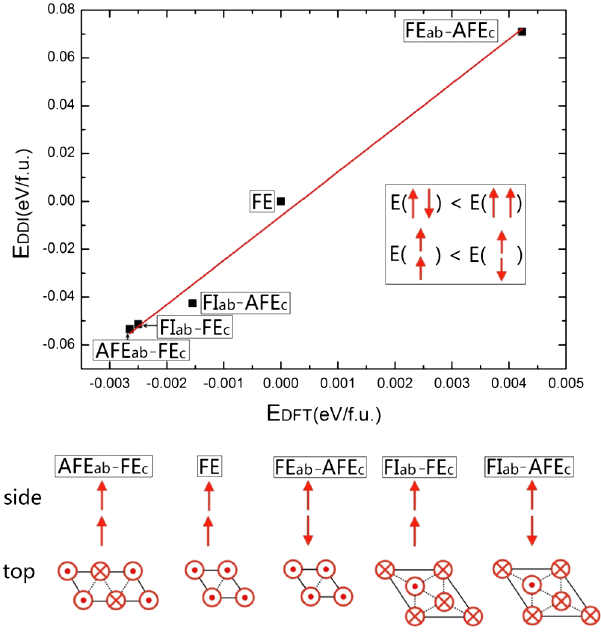
FIG. 2 Comparison of the results from the DDI model with those from the DFT calculations. The top panel plots the energies from the DDI model against the DFT energies for five different configurations (i.e., FE, AFE ab − FE c , FE ab − AFE c , FI ab − FE c , FI ab − AFE c ) of the local dipoles. The zero-energy reference is taken to be that of the FE state. A straight ¼ 18 . 5 E þ c ) is also shown. line from the linear fitting ( E DDI DFT The inset in the top panel schematically illustrates the idea that the two in-plane dipoles tend to be antiparallel to each other, while two dipoles along the c axis tend to be parallel to each other. The five dipole configurations are shown in the bottom panel. For the side view, we only indicate whether the dipole arrangement along c is AFE or FE. For the top view, crossed circle (dotted circle) represents the dipole along c ( − c ). The NN in-plane dipoles are connected by dashed lines. The solid lines denote the in-plane unit cell of the dipole